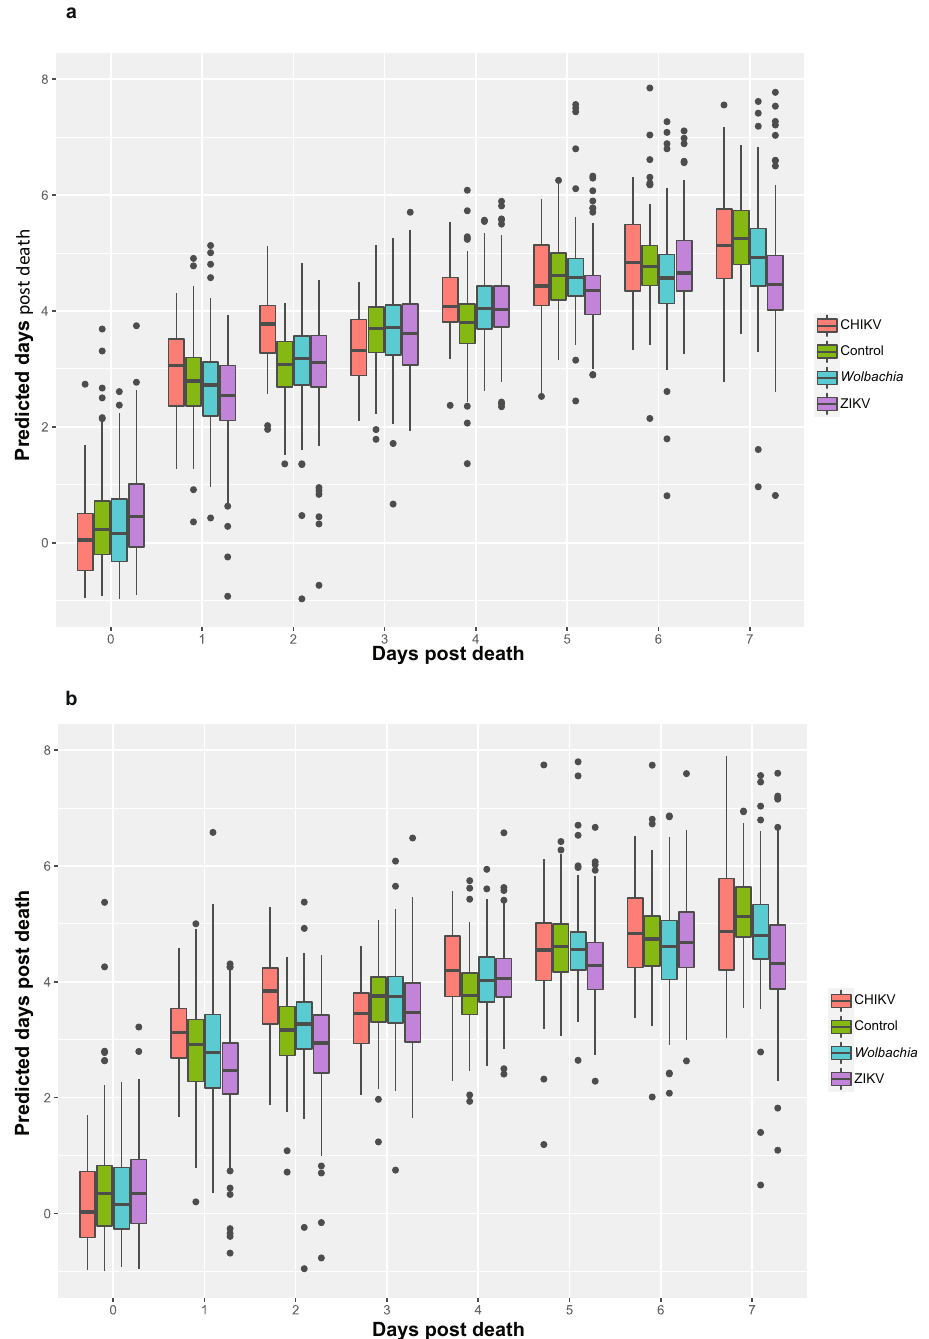
Fig. 1 Death prediction model by days post death and infection status. Results from training data ( a ) and results from testing data ( b ). Monte Carlo simulations were performed using a 75%/25% training/testing split to validate the model. Infection status including CHIKV (red), ZIKV (purple), Wolbachia (blue), and uninfected controls (green) is presented in both panels. Box and whisker plots follow the standard convention where the box represents the range between quartiles 1 and 3, while the whiskers represent maximum and minimum excluding outliers. Outliers are de fi ned as either Q1 − 1.5 × IQR or Q3 + 1.5 ×